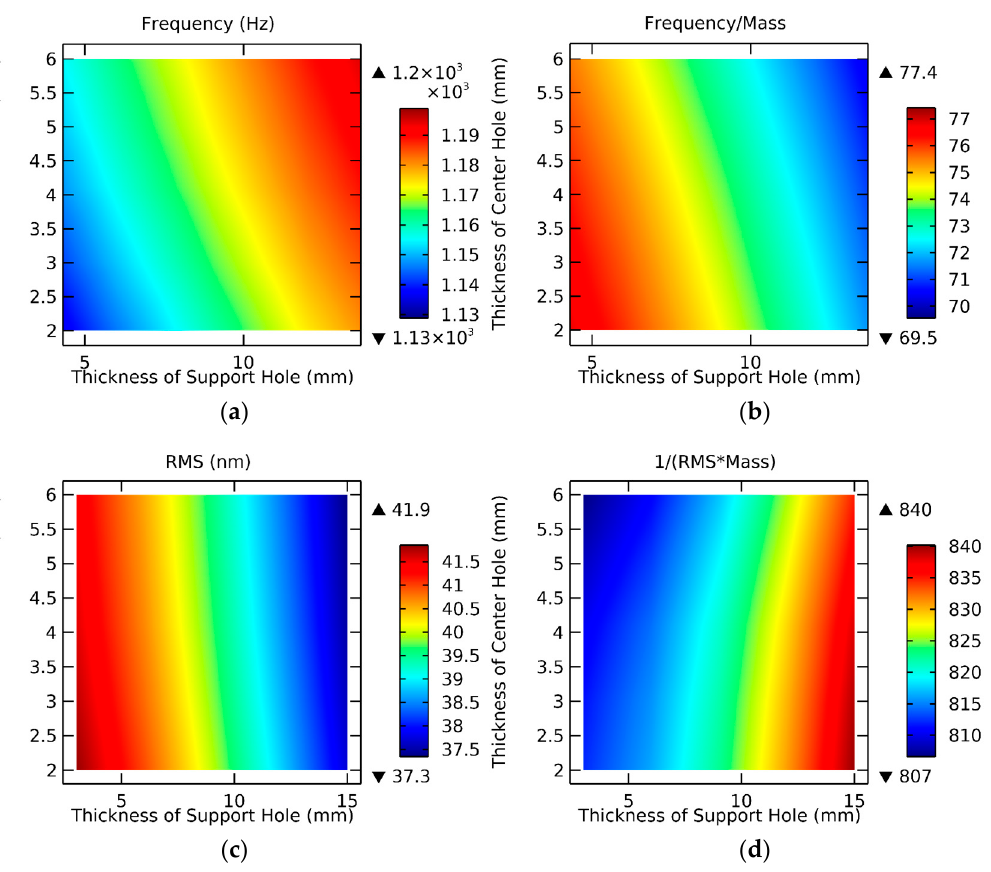
Figure 6. Performance analysis of the thickness of the support hole and center hole under different parameters. ( a ) Frequency; ( b ) Frequency/Mass; ( c) RMS; ( d ) 1/(RMS*Mass).